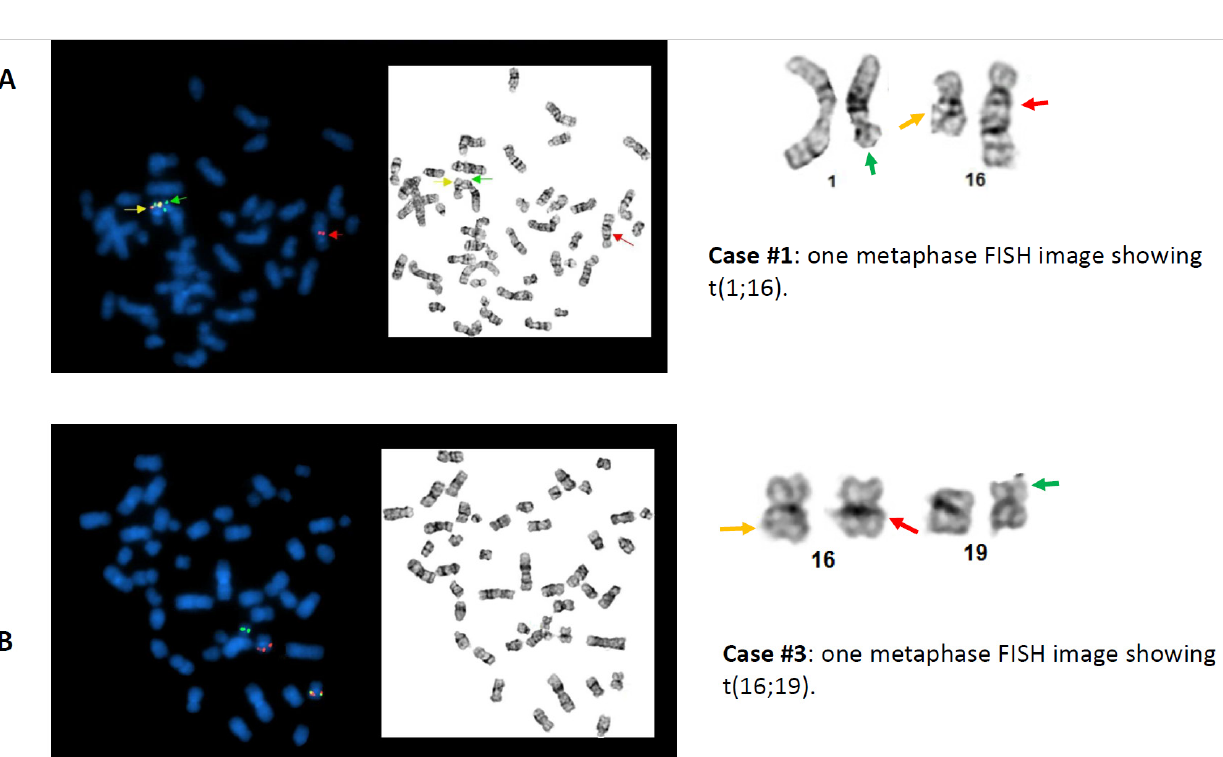
Figure 1. Schematic illustration of CBFB break-apart (BAP) and CBFB-MYH dual fusion (DF) FISH probe sets applied in this study. Information was obtained from the user’s guide provided by the manufacturers. ( A ) . CBFB BAP probe set with coverages of 5 ′ CBFB and flanking region (~ 130 kb) labeled with red dye, and 3 ′ CBFB and flanking region (~ 204 kb) labeled with green dye. ( B). CBFB-MYH11 DF probe set with coverages of CBFB and flanking region (~ 1270 kb) labeled with red dye, and MYH11 and flanking region (~ 1080 kb) labeled with green dye. The sizes are not to scale.